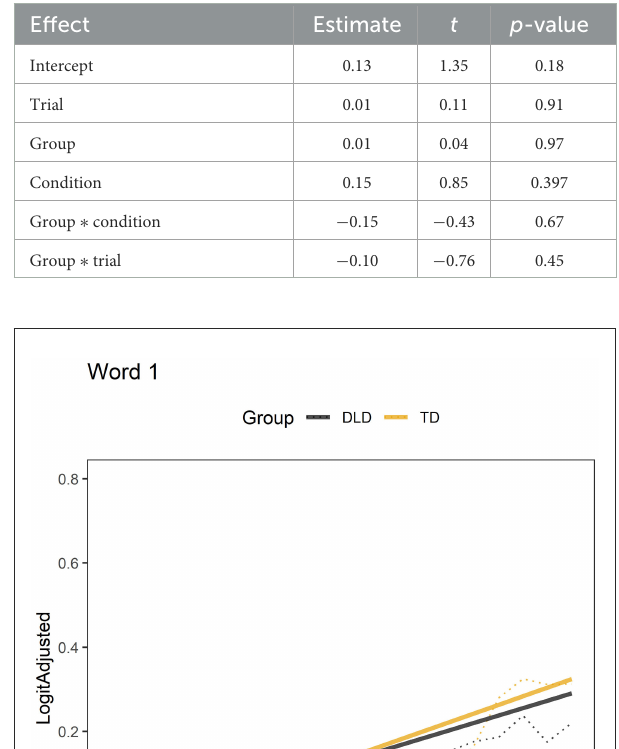
TABLE 3 Outcomes of the linear mixed-effects model for Word1: sanity checks and confirmatory results.